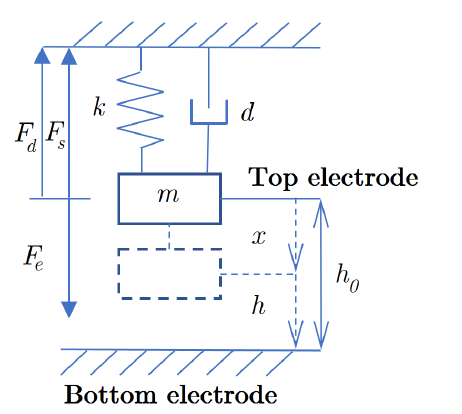
Figure 2. Equivalent mechanical diagram of our capacitive microactuator. The initial position of electrodes without electrostatic force is h 0 ; the deflected position (due to attractive electrostatic force) is h